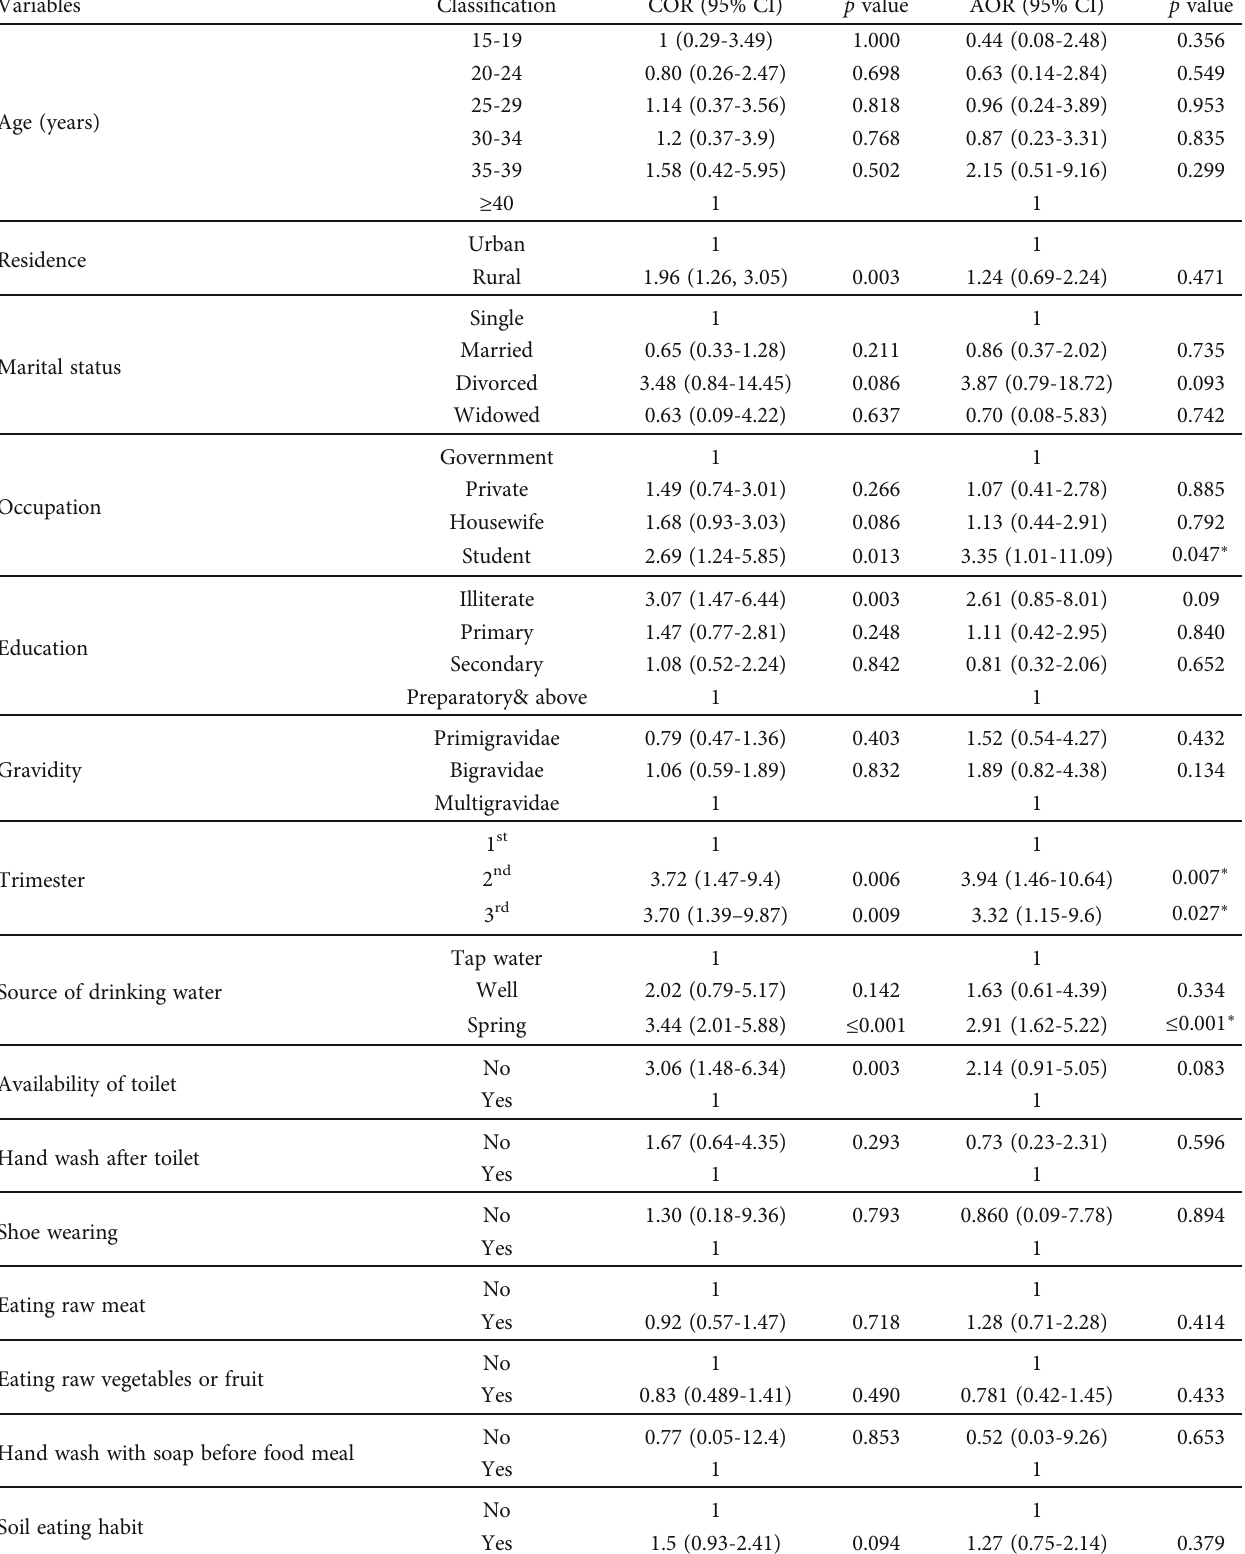
Table 3: Logistic regression analysis of intestinal parasitic infection across sociodemographic and other associated risk factors